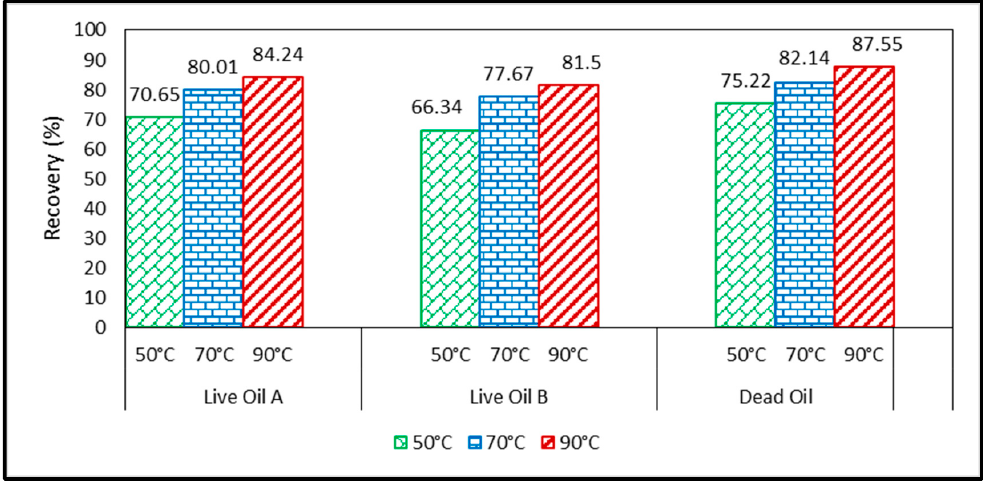
Figure 3. Comparison of ultimate oil recovery for model live oils A&B and dead oil (n-C10) at 50 °C, 70 °C, and 90 °C.